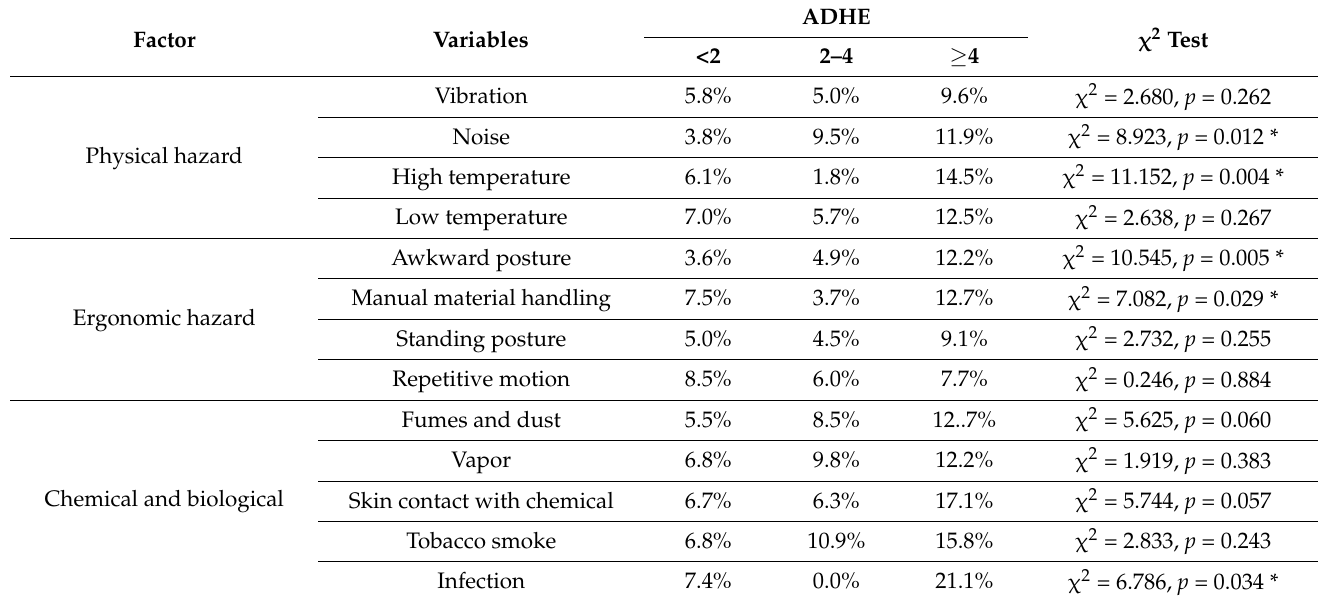
Table 7. Distribution of subjective backache by the degree of hazard exposure.